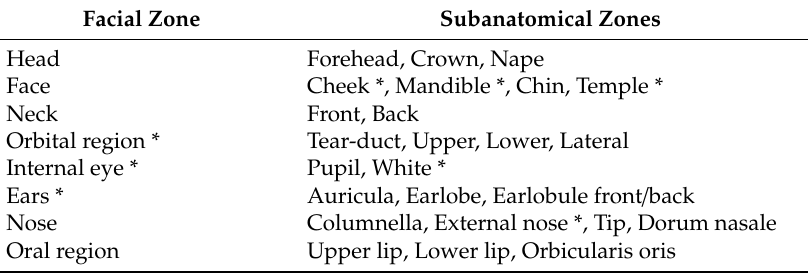
Table 2. Detailed anatomical regions and subregions for the facial